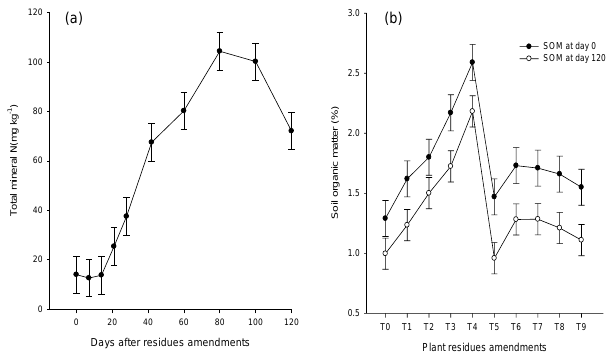
Figure 3. Mineralization trend of added plant residues across tim- ings (a) and soil organic matter (SOM) turnover of different plant residues recorded at the start of the experiment on day 0 and at the end of incubation on day 120 (b) . The hanging bar on each major line represents the LSD ( p ≤ 0.05) between incubation periods and between each